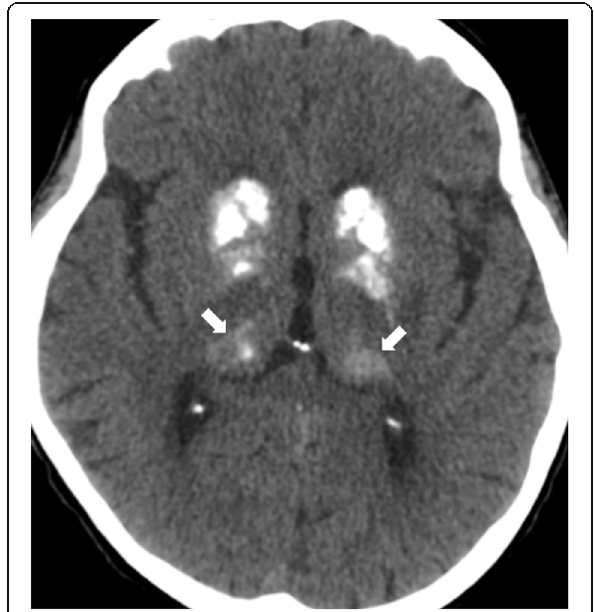
Fig. 6 High attenuation in the basal ganglia and thalami (arrows) on non-contrast CT due to calcifications in a patient with Fahr ’ s disease